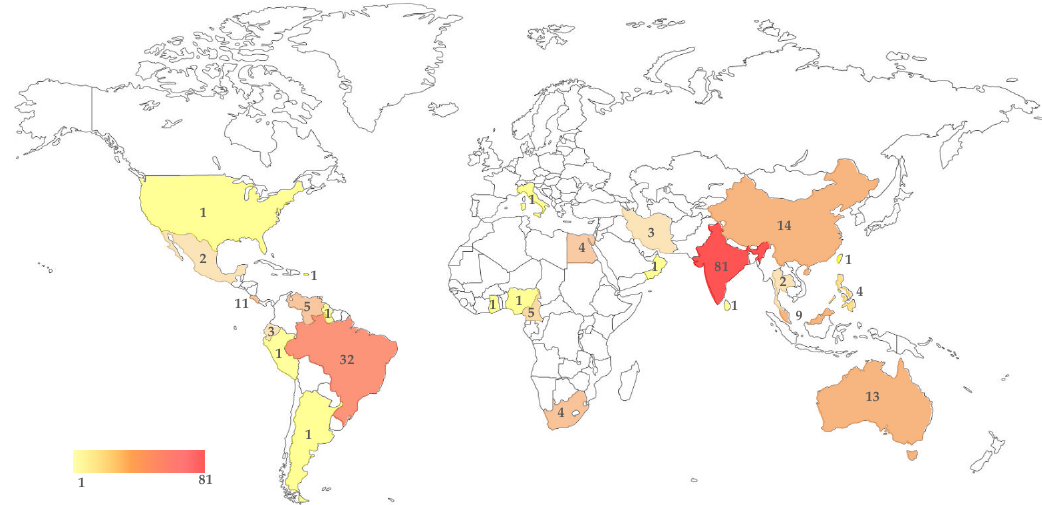
Figure 1. Geographical distribution of endophytic Lasiodiplodia theobromae as resulting from entries of Table 1. The color scale ranging from yellow to red is representative of the number of findings for each country.